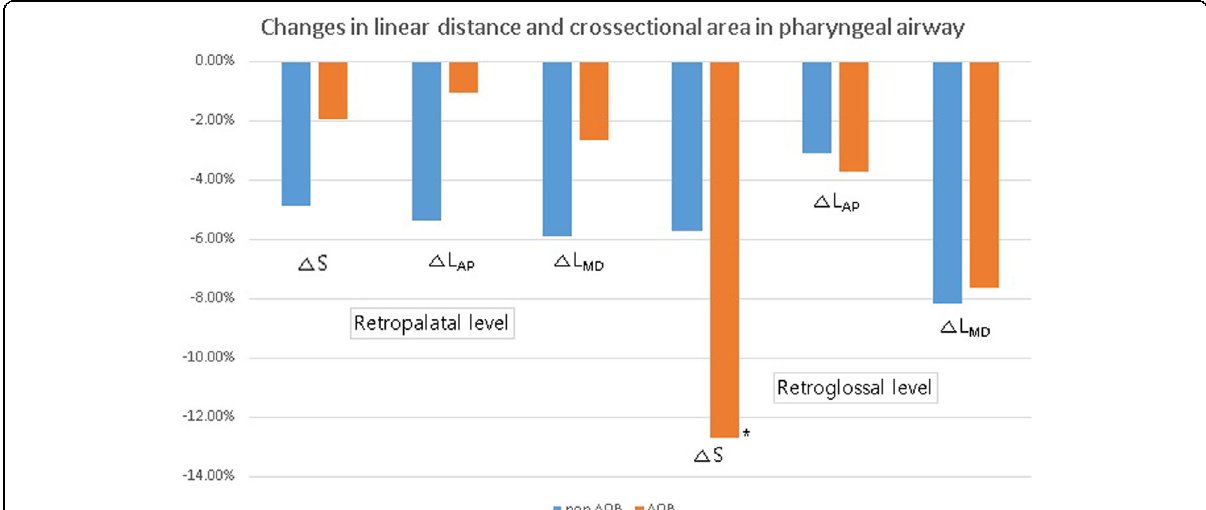
Fig. 3 The average change in the pharyngeal airway volume. The postoperative airway volume was significantly decreased in both the groups (* p = 0.006 and * p = 0.003), even though the difference between the two groups was not statistically significant